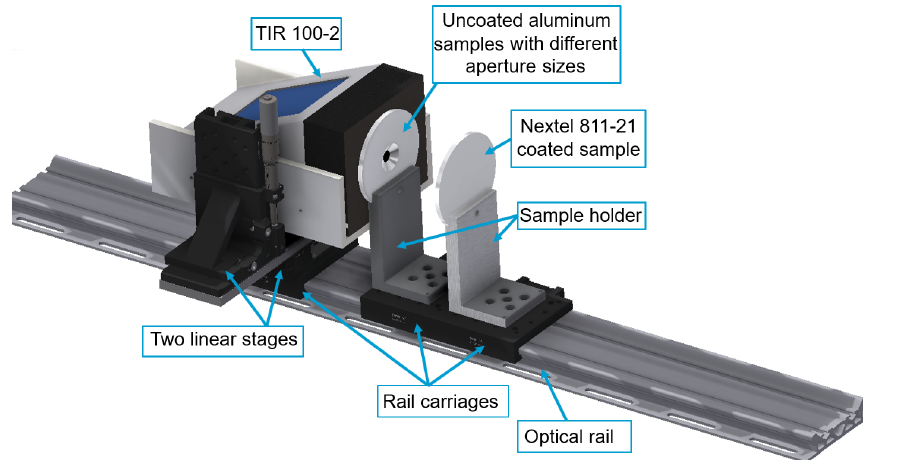
Figure 2. Setup for characterization of the measurement field of the TIR 100-2. For the scanned aperture method, an aperture with a fixed diameter of 6mm was used. For the varied aperture method, aperture diameters ranged from 1 to 32mm.